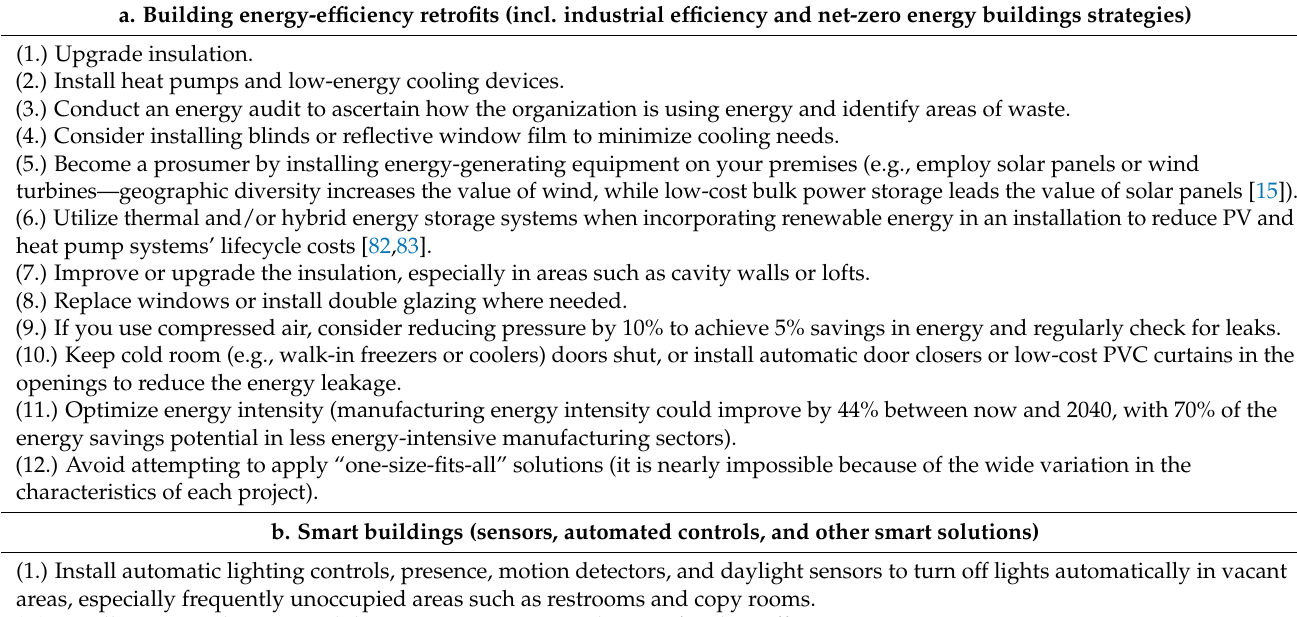
Table 3. “Hard” interventions—effective strategies for organizational energy efficiency and conserva- tion through building retrofitting, automation, rules, and policies. Effective Strategies for Organizational Energy Efficiency and Conservation in “Hard” Interventions (Compiled and Adapted Insight from